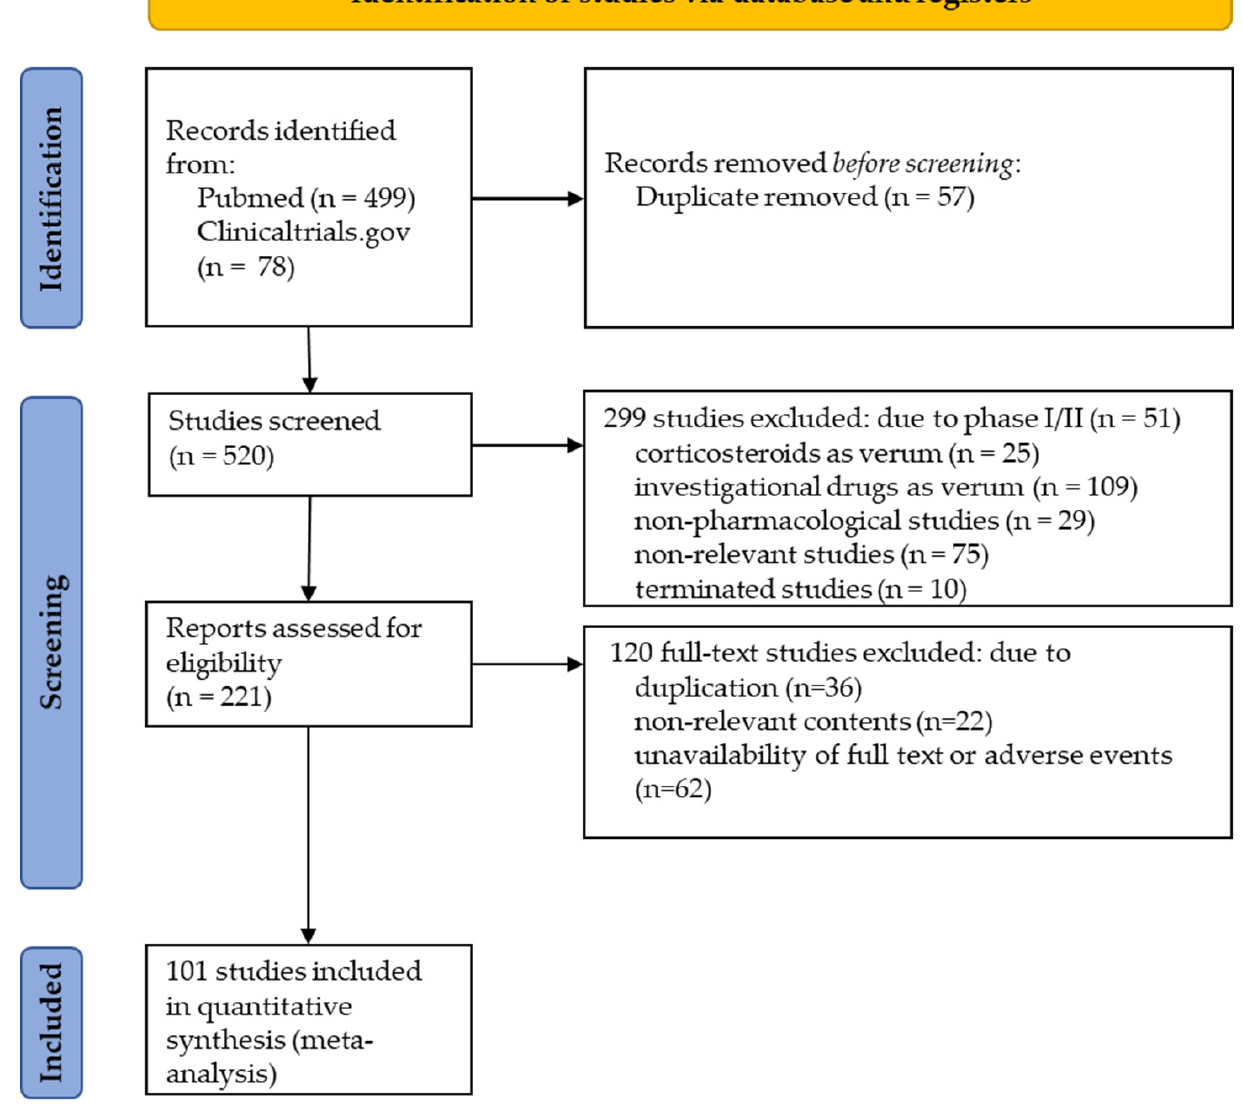
Figure 1. Flow diagram of record selection according to the PRISMA-P strategy.